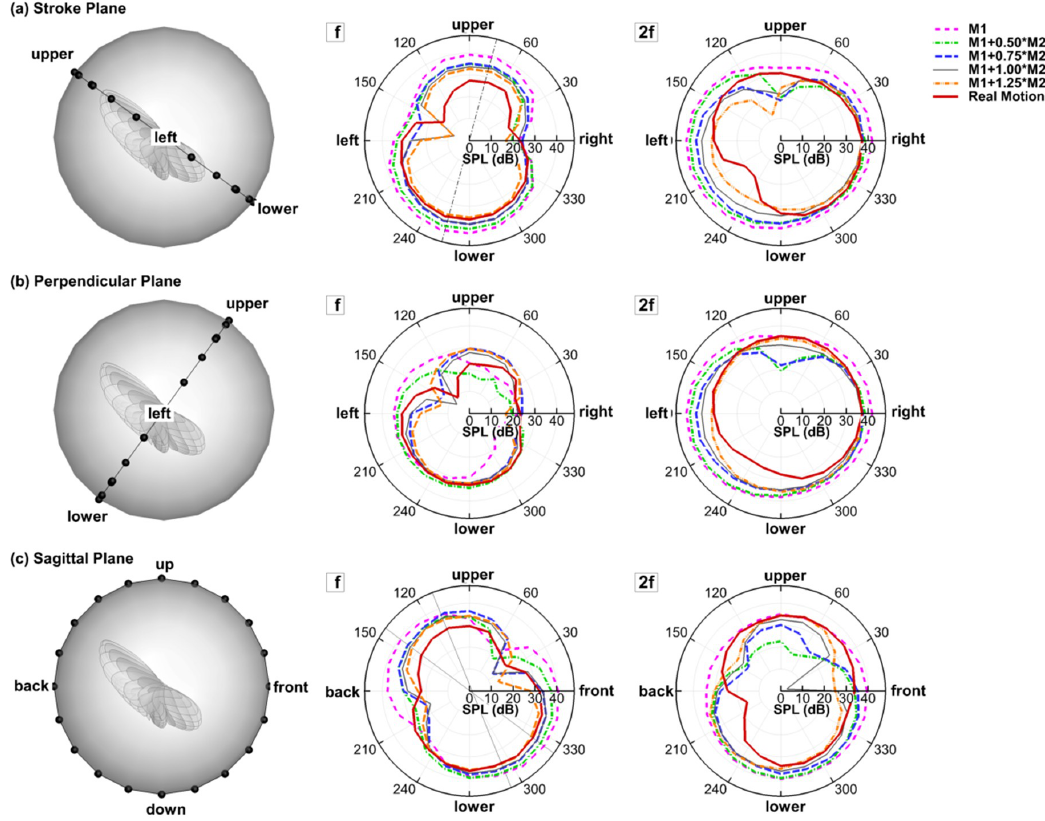
Figure 4. Juxtapostion of sound pressure level (SPL) (dB) distribution of all the models for each of the the harmonics at r = 75 c in the ( a ) stroke plane; ( b ) perpendicular plane; ( c ) saggital plane.